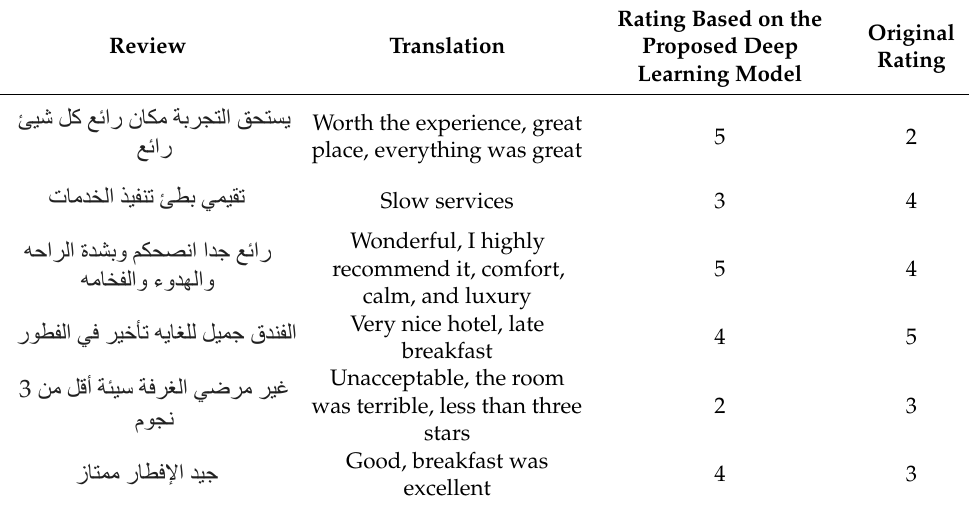
Table 3. Examples of the disagreements between the original reviews rating and the rating of the developed deep learning-based sentiment analysis model.